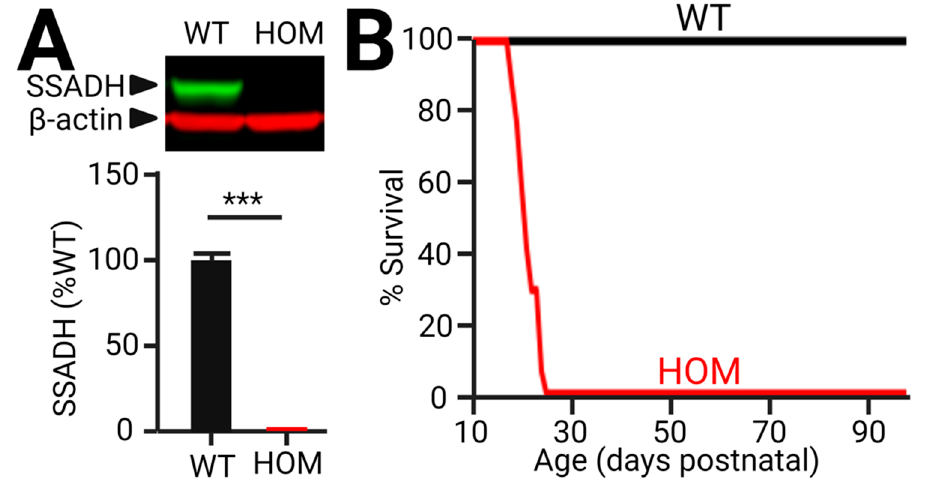
Figure 5. Cortical expression of SSADH and survivability of aldh5a1 STOP/STOP mice. ( A ) Western blot analyses of cortical lysates from wild-type (WT) and homozygous mutant (HOM) aldh5a1 STOP/STOP mice at postnatal age of 16 days. β -actin serves as protein loading control. Quantification of SSADH expression is expressed as % WT, showing HOM mice have virtually no SSADH expression. Values = Mean ± SEM. *** p < 0.001, unpaired t -test, n = 10 WT, 8 HOM mice. Both male and female mice were used. ( B ) Survivability of WT and HOM mice across development. Note a sharp plunge in HOM survival rate that occurs around postnatal age of 20–25 days, while no lethality was observed in WT. n = 30 WT, 17 HOM mice.